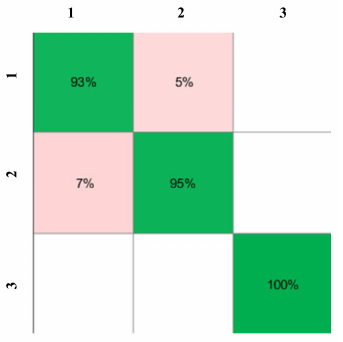
Figure 9. Identification results of the proposed